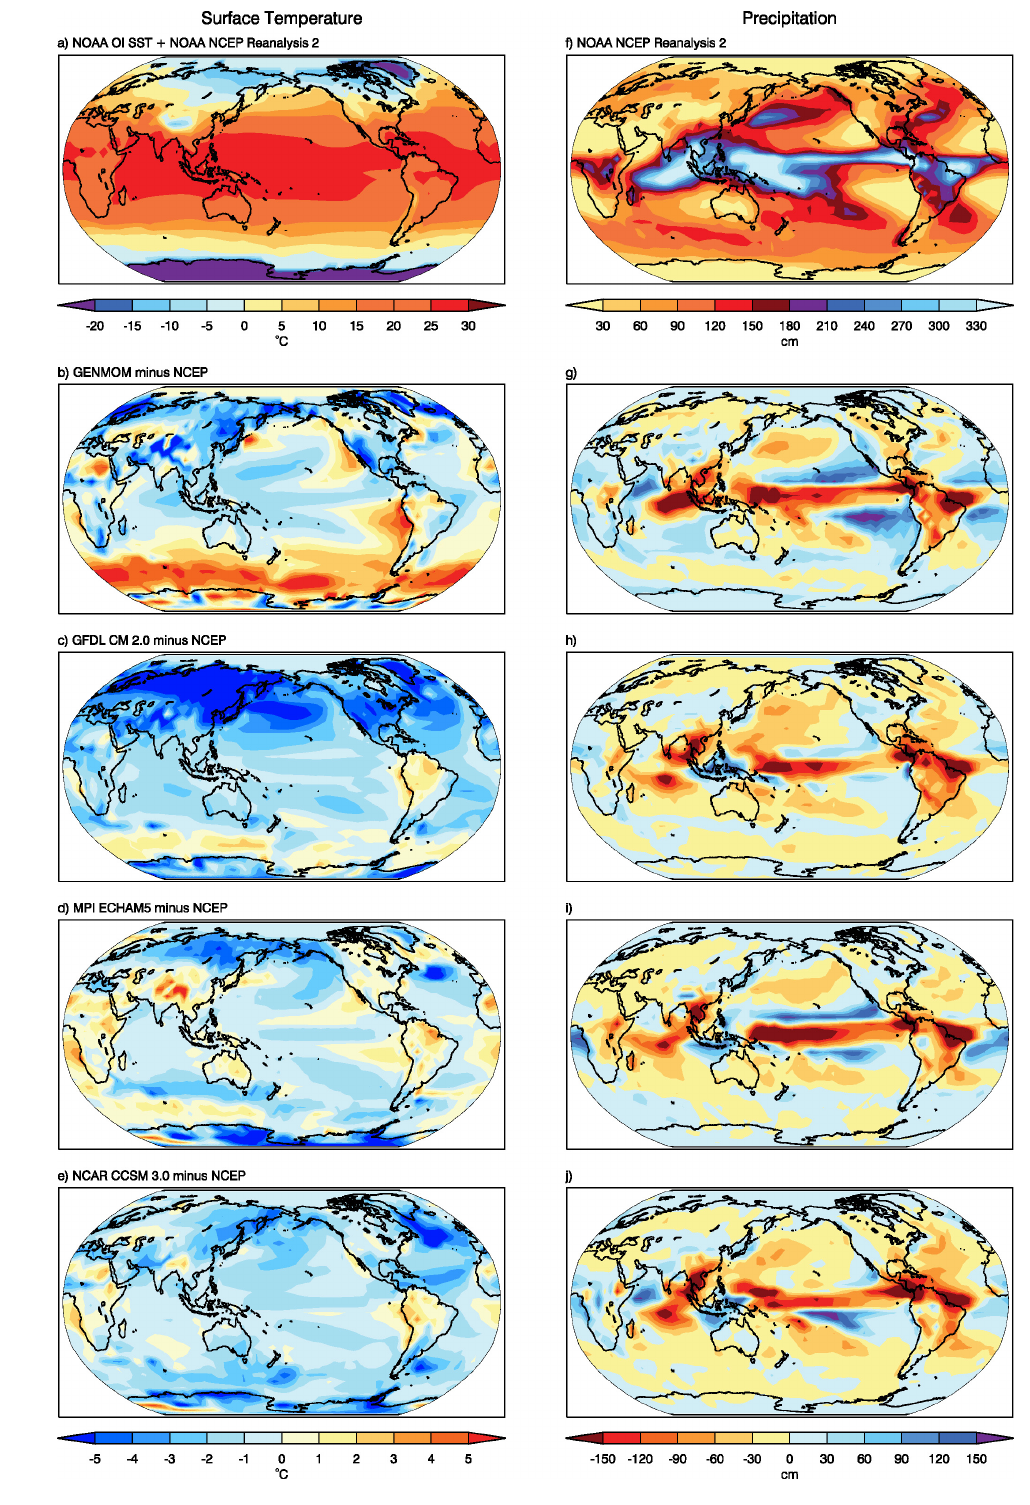
Fig. 4. Annual surface temperature (a) with model anomalies (b–e) and annual total precipitation (f) with model anomalies (g–j) from GENMOM and three AOGCMs included in the IPCC AR4. Observed data are from NOAA NCEP Reanalysis 2 (over land) and NOAA OI SST (over sea). GENMOM 2m air temperature and SST are for model years 670–699 of the control equilibrium simulation. The three IPCC AR4 models are averaged over the last 30 years (1970–1999) of the Climate of the 20th Century experiment. All data are bi-linearly interpolated to a 5 ◦ × 5 ◦ grid. Anomalies are calculated as simulation –